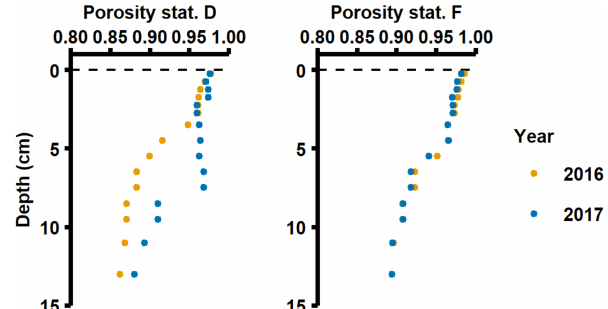
Figure A5. Porosity profiles from stations D and F in 2016 and 2017.